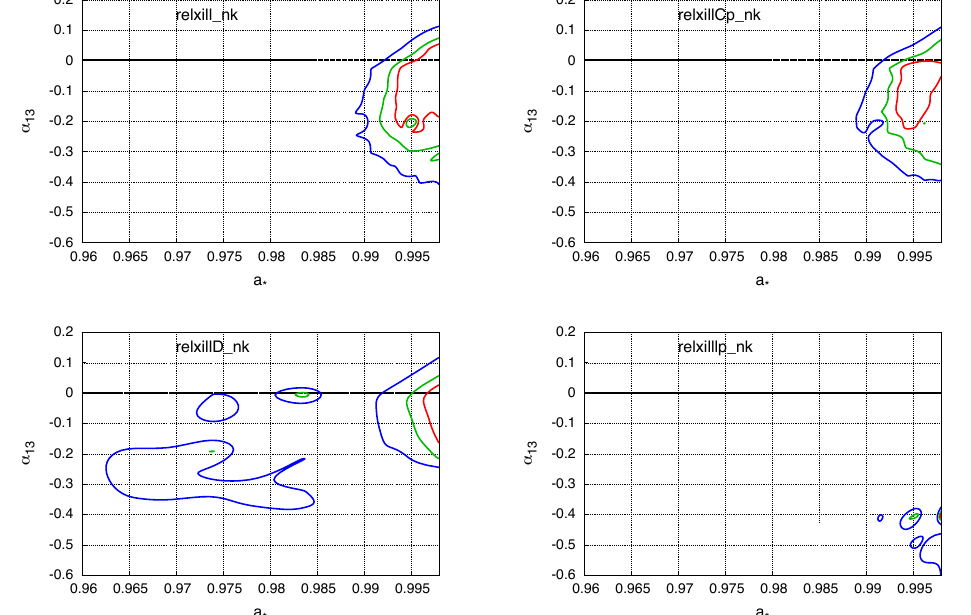
Figure A11. Constraints on the spin parameter a ∗ and the Johannsen deformation parameters α 13 for PKS 0558–504 when the reflection component is modeled by RELXILL _ NK ( top left panel ), RELXILL C P _ NK ( top right panel ), RELXILL D_ NK ( bottom left panel ), and RELXILLLP _ NK ( bottom right panel ). The red, green, and blue curves are, respectively, the 68%, 90%, and 99% confidence level boundaries for two relevant